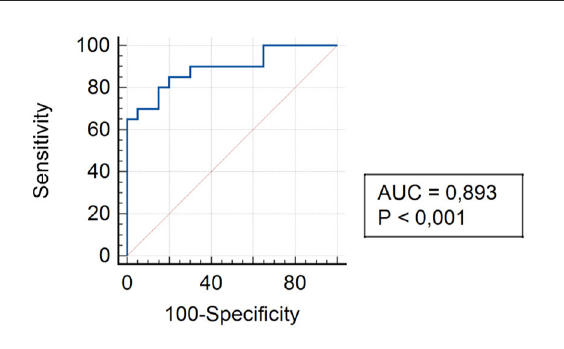
FIGURE5 ROC curve for TLR4 expression in patients of Group II 3 and 6 months after surgery.